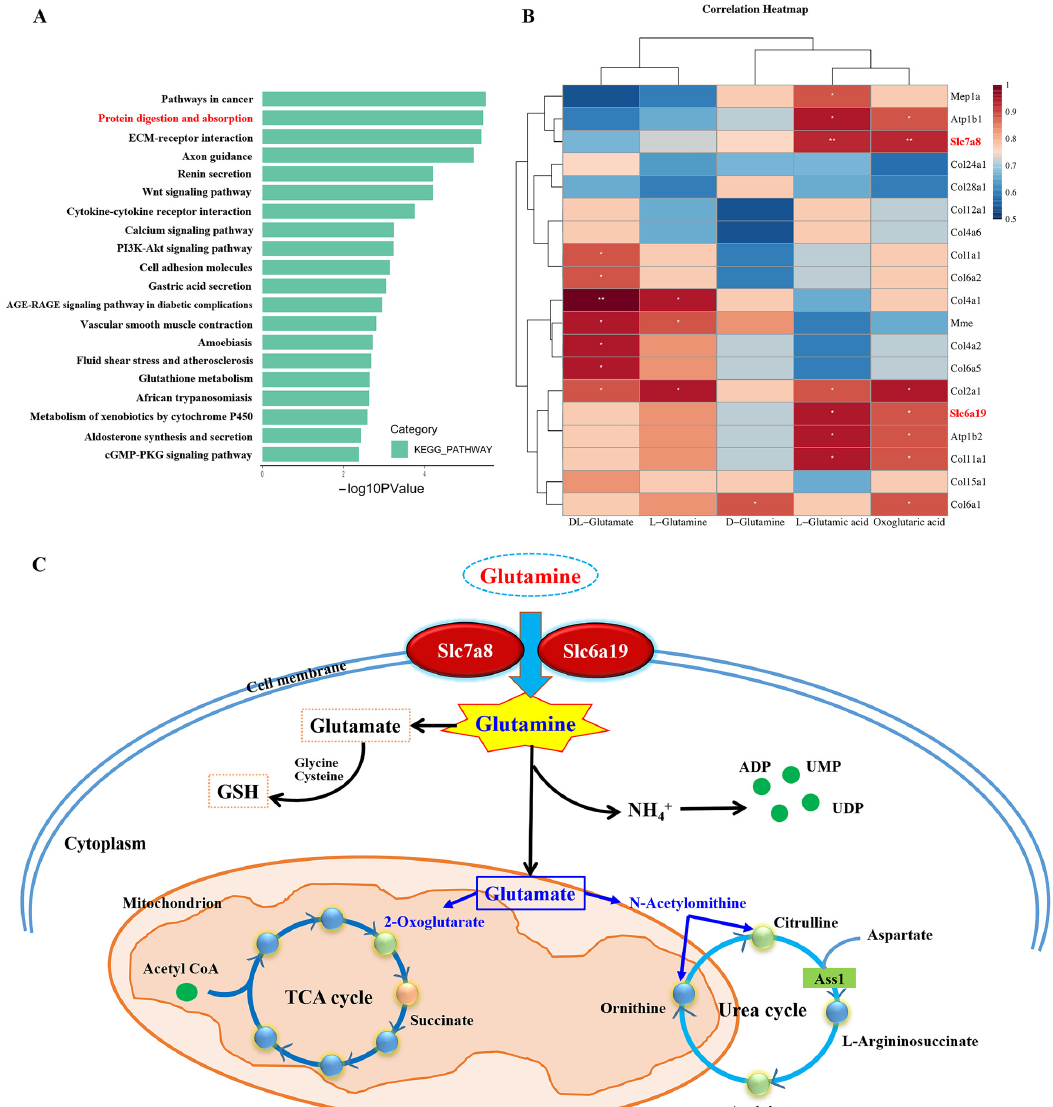
Figure 4. Slc7a8 and Slc6a19 influence the D-glutamine and D-glutamate metabolism pathways by reducing the influx of glutamine into cells ( Slc7a8 , solute carrier membrane transport protein, family 7, subfamily A, member 8, large neutral amino acids transporter, Slc6a19 , solute carrier membrane transport protein, family 6, subfamily A, member 19, sodium-dependent neutral amino acids transporter). ( A ) KEGG analysis of significantly downregulated genes showed protein digestion and absorption pathway enrichment. ( B ) Association analysis of genes in the protein digestion and absorption pathway with products involved in D-glutamine and D-glutamate metabolism. Slc7a8 and Slc6a19 encode proteins that mediate transmembrane import of glutamine that are significantly associated with metabolites. ( C ) Scheme of metabolism in KO cells. Spearman’s test was used for correlation calculation, ** p < 0.01, * p < 0.05 (PI3K, phosphorinositide 3-kinaseS, cGMP, cyclic guanosine monophosphate, PKG, protein kinase G, GSH, glutathione, ADP, adenosine diphosphate, UMP, uridine monophosphate, UDP, uridine diphosphate, and mention the meanings of col, collagen, mep , 2-C-Methyl- D-erythritol 4-phosphate, mme , membrane metalloendopeptidase, ATP, adenosine